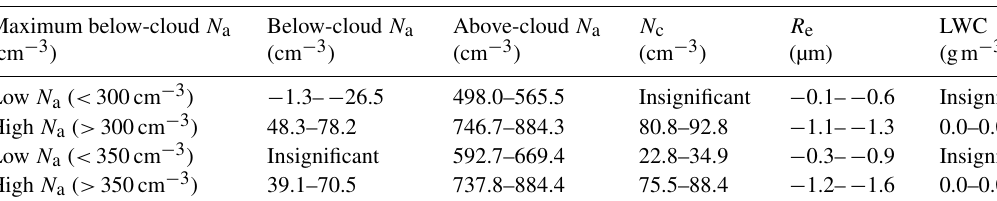
Table 5. Aerosol and cloud properties were averaged across all contact and separated profiles flown in low- N a and-high N a boundary layers. These averages were compared between contact and separated profiles. The values listed below represent the 95% confidence intervals (from a two-sample t test) when the differences were statistically significant. Positive values indicate the average for contact profiles was higher, and “insignificant” denotes the differences were statistically insignificant.